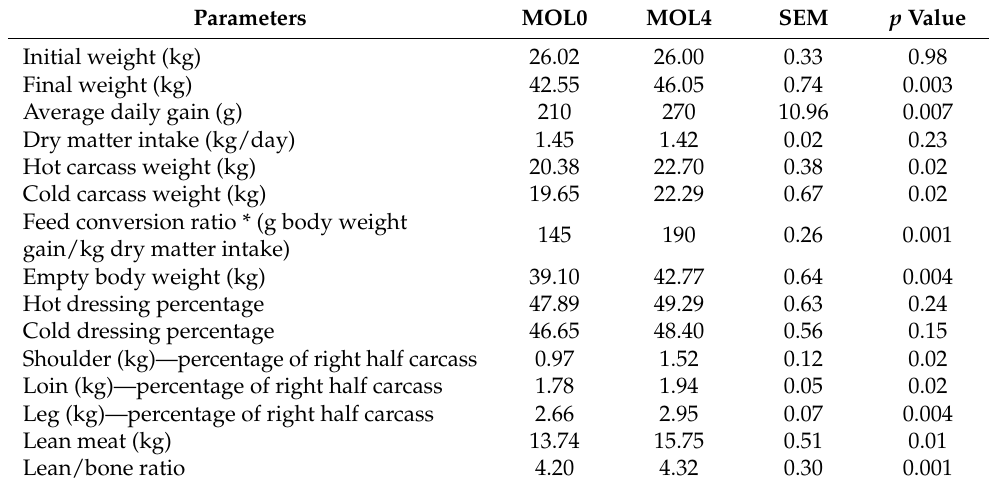
Table 2. Effect of diets on dry matter intake and some performance parameters of studied